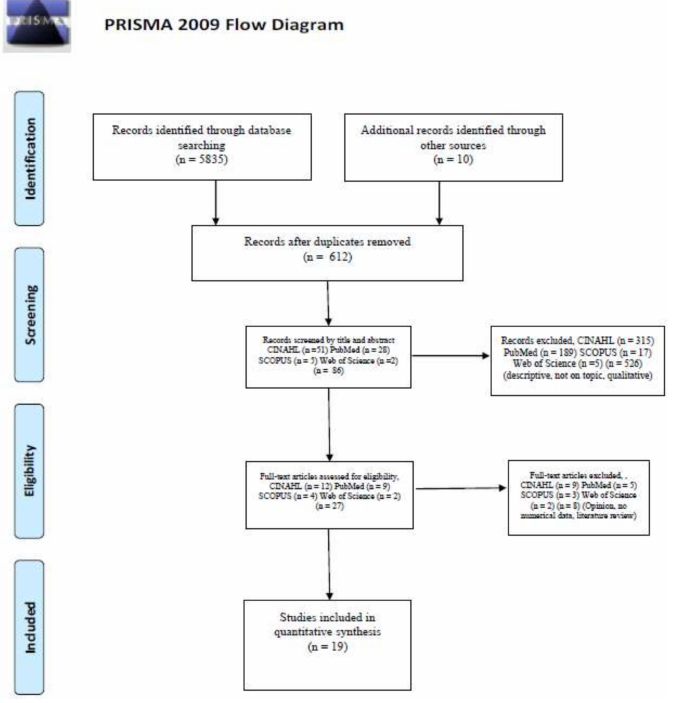
Figure 1. Systematic review flow